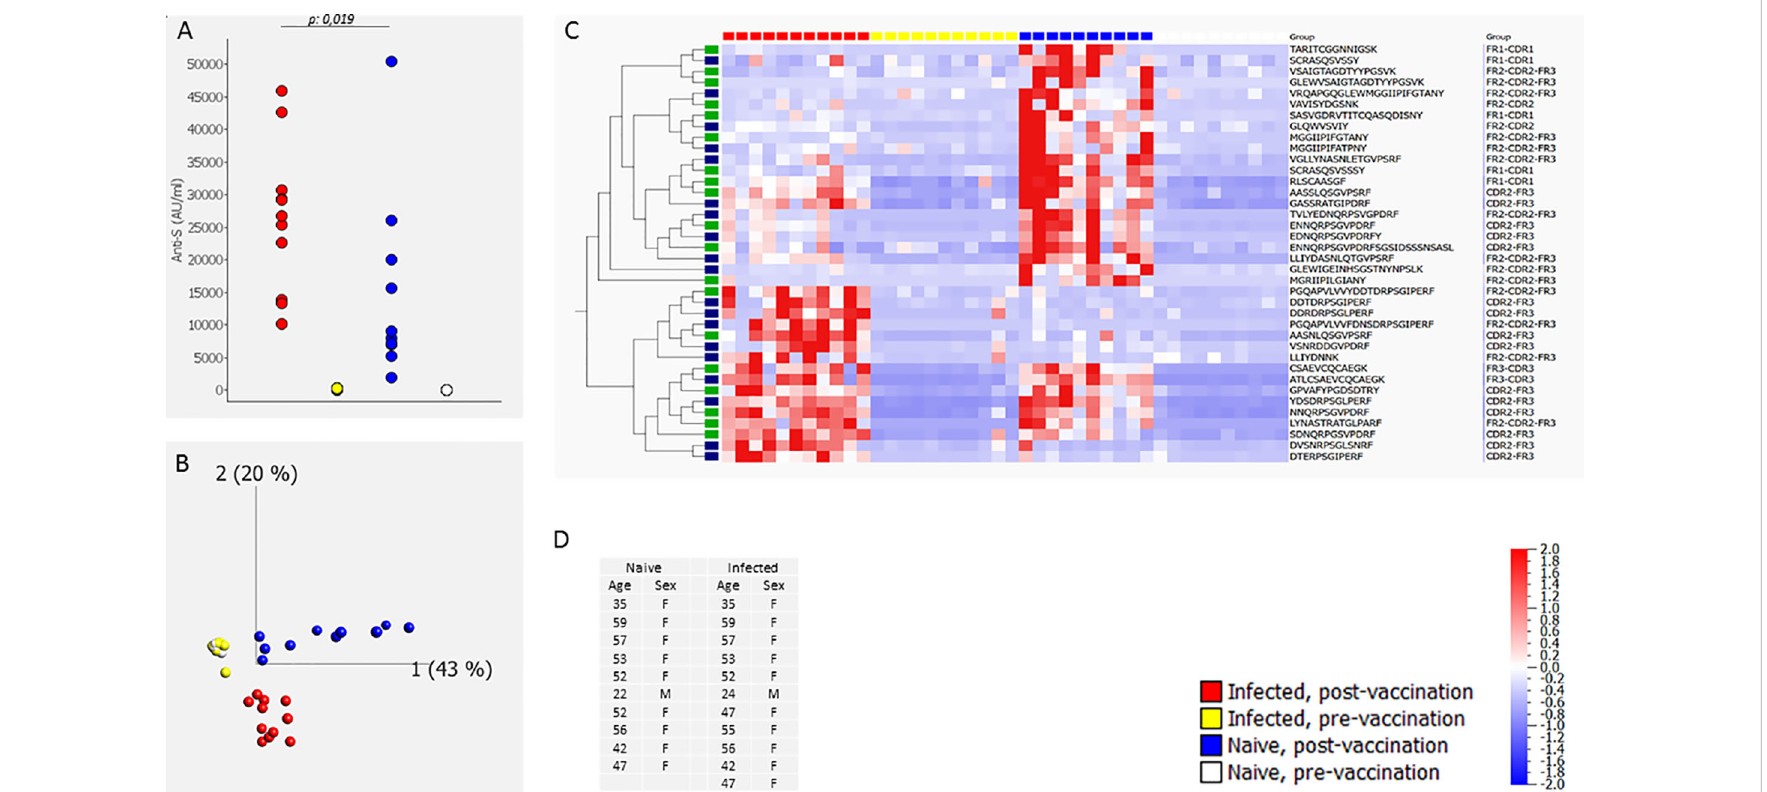
FIGURE 1 CDR pro fi le and IgG anti-S antibodies before and after two doses of the BN162b2 vaccine [6 weeks (40-45 days) after fi rst dose, three weeks after the second dose] in naïve individuals and in individuals that had been infected with SARS-CoV-2 before vaccination (determined by a positive SARS-CoV-2 PCR on a respiratory sample or presence of IgG anti-S and/or IgG anti-N in serum before infection) (experiment #1). The fi gure shows the anti-S antibody levels (A) , the PCA analysis (B) , heat map after hierarchical clustering of the CDR features (C) and age and gender distribution of the included individuals (D) . The heat map indicates the variance (from -2 to 2) compared to the mean (0) for each peptide feature. The included vaccination/infection-induced CDR-derived peptides were those that revealed discriminative by sPLS-DA analysis. The green- labeled CDR-derived peptides were also revealed discriminative by sPLS-DA analysis in experiment #2 (Extended Data Figure 2). The median [25 th -75 th percentile] anti-S antibody levels (AU/mL) were 2 [1.8-3.3], 8483 [7028-18901], 122 [86-243], and 26771 [18235-30021] pre-vaccination naïve, post-vaccination naïve, pre-vaccination infected and post-vaccination infected,